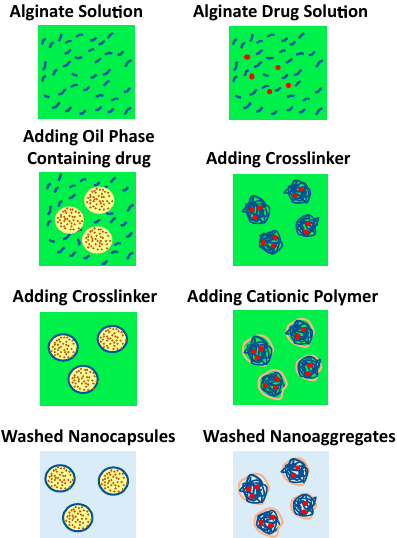
Figure 5. Schematic presentation of alginate nanocapsules and nanoaggregates formation via complexation method.